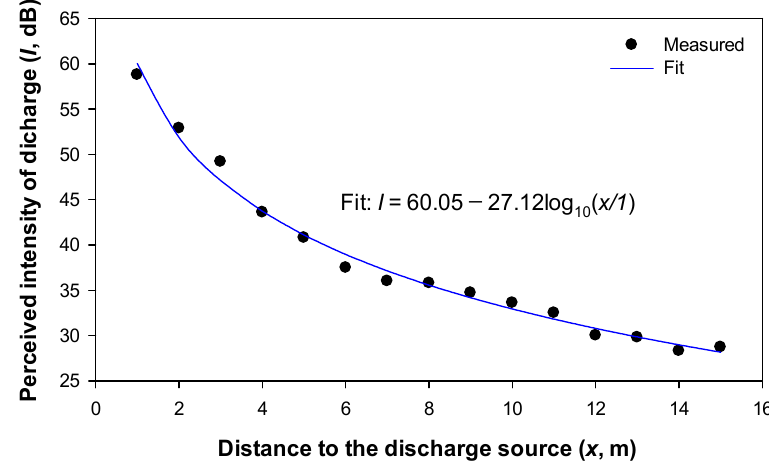
Figure 9. Logarithmic decay of the sound intensity of the discharges that were detected by the acous- tic NL camera. Experimental points and logarithmic fit ( R 2 = 0.9891) that was measured with the sphere-plane gap with 50 Hz ac